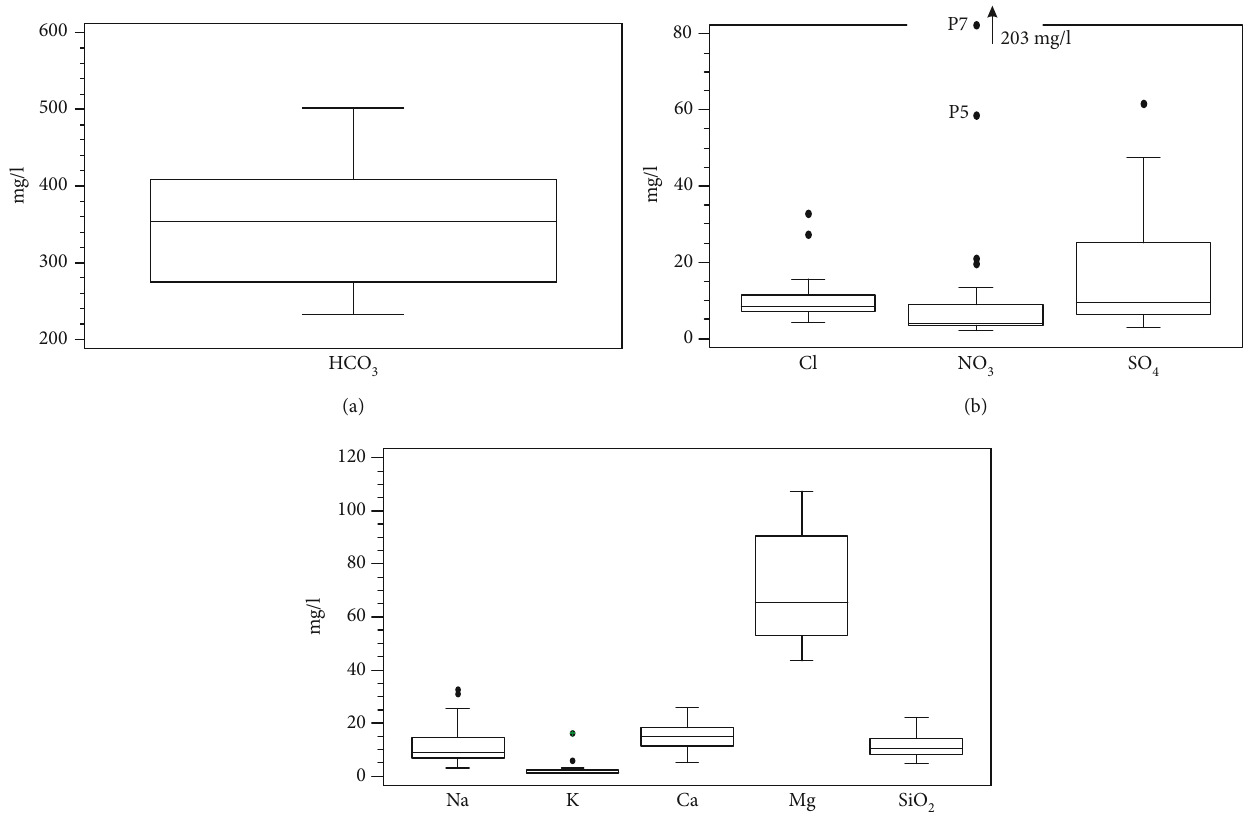
Figure 3: Box-and-whisker plots for major elements (cations and